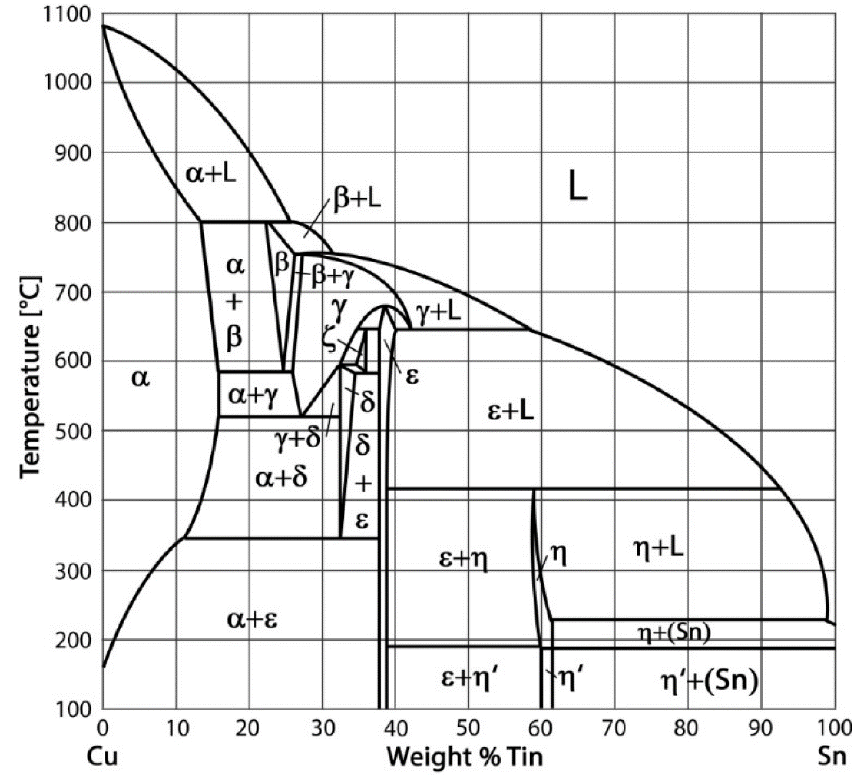
Figure 3. Cu-Sn phase diagram